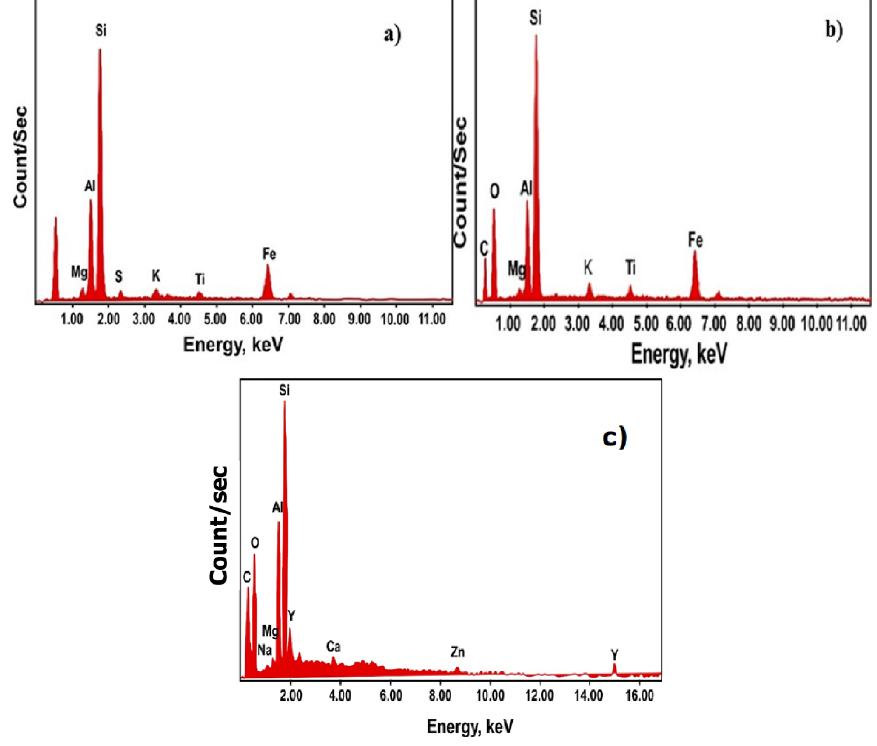
Figure 8. EDX spectra of ( a ) treated bleaching clay, ( b ) AHIBC, and ( c ) Y(III) loaded on